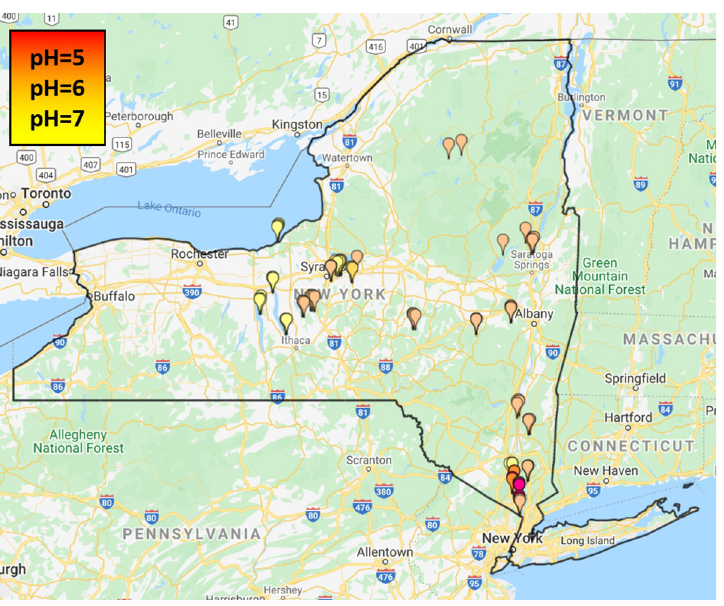
Fig 3. Predicted pH by the random forest for all sampling locations. Republished from [31] under a CC BY license, with permission from ZeeMaps, original copyright 2005.